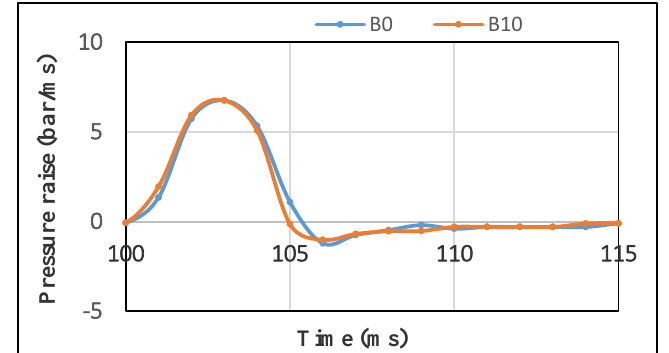
Figure 13. Pressure raise in CVCC.